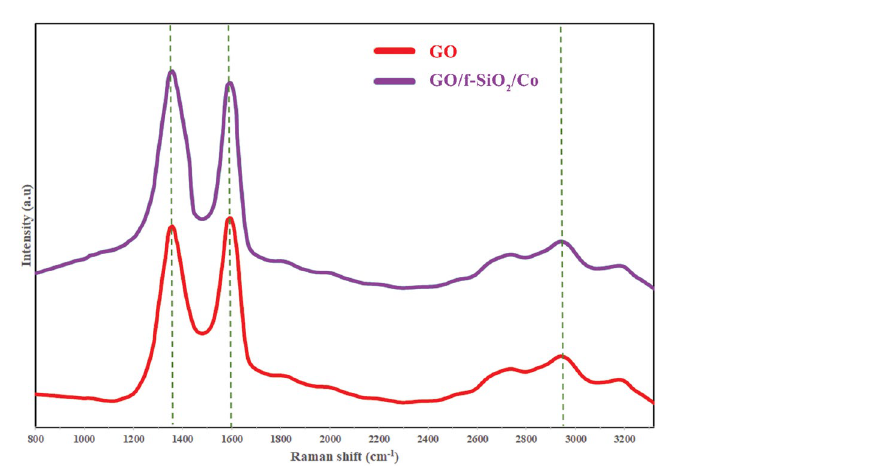
Figure 6. The Raman spectra of GO ( a ), GO/f-SiO 2 /Co ( b